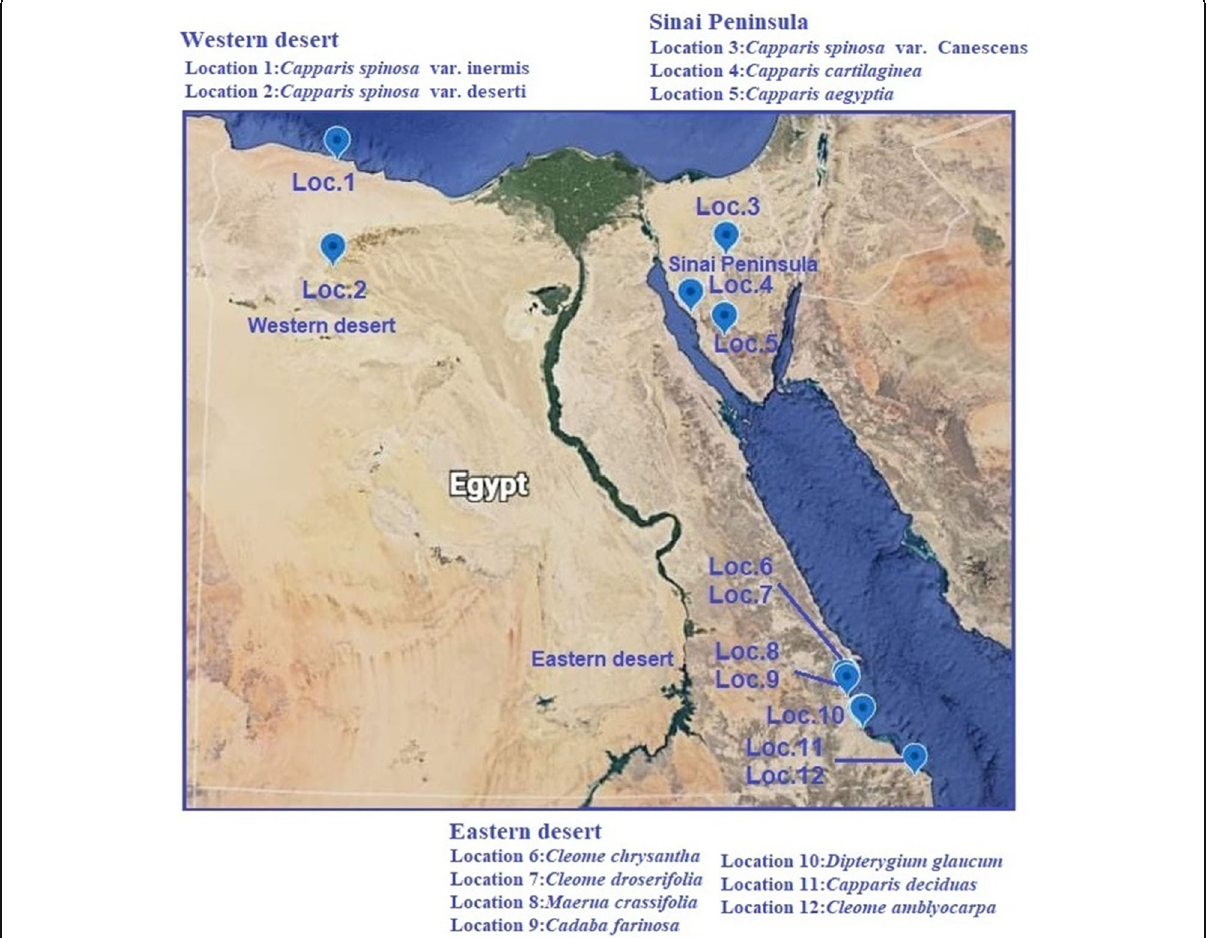
Fig. 1 Map showing the distributions and locations of 12 Capparaceae species within Western, Eastern desert, and Sinai Peninsula in